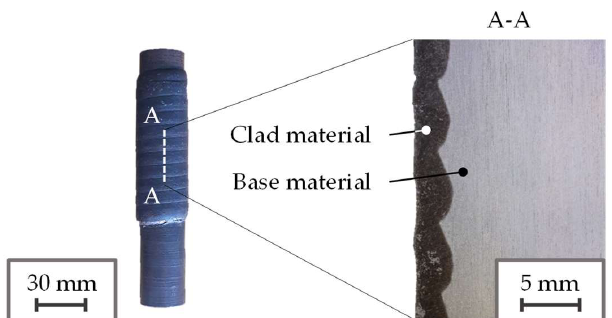
Figure 2. Material distribution in plasma transferred arc (PTA) cladded workpiece for a 41Cr4/C22.8